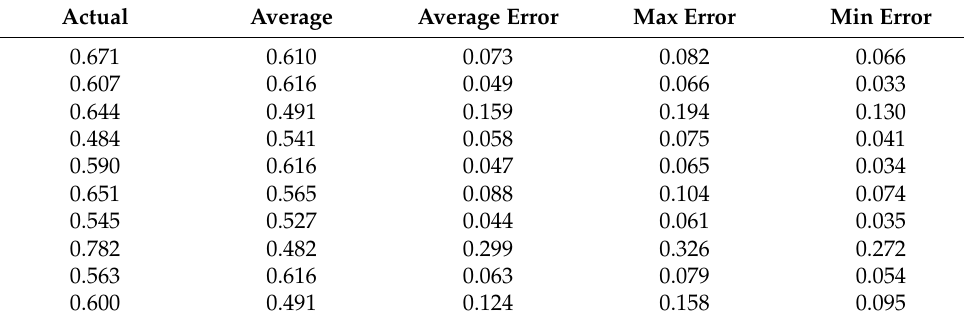
Table A110. Set 2, trials 21–30 data (single 0.5 PR value).